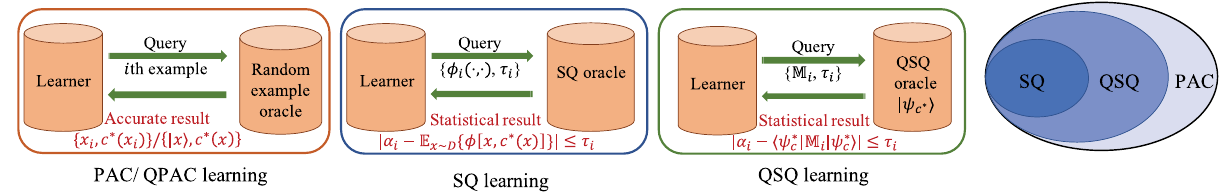
FIG. 3. The mechanism of different quantum learning models. The key difference of PAC (or QPAC), SQ, and QSQ learning is the way to acquire accessible data information, which is used to infer hypothesis h ( · ) . In particular, the left panel exhibits the mechanism of PAC or QPAC learning. To inference h ( · ) , the PAC learner requires access to the example oracle to acquire the accurate information of each example. The two middle panels represent the mechanism of SQ and QSQ learning, respectively. The SQ (QSQ) learner feeds a sequence of queries { [ φ i ( · , · ) , τ i ] } into a SQ (QSQ) oracle and receives the statistical results { α i } about the target concept c ∗ ( · ) . The collected results { α i } are then employed to infer the hypothesis h ( · ) to approximate c ∗ ( · ) . The right panel compares the power of SQ, QSQ, and PAC learning modes. Namely, restricted by the accessible information of the dataset, some problems can not be efficiently tackled by SQ and QSQ learning models, while they can be effectively solved by PAC learning models. number of trainable parameters is 15 and 60,